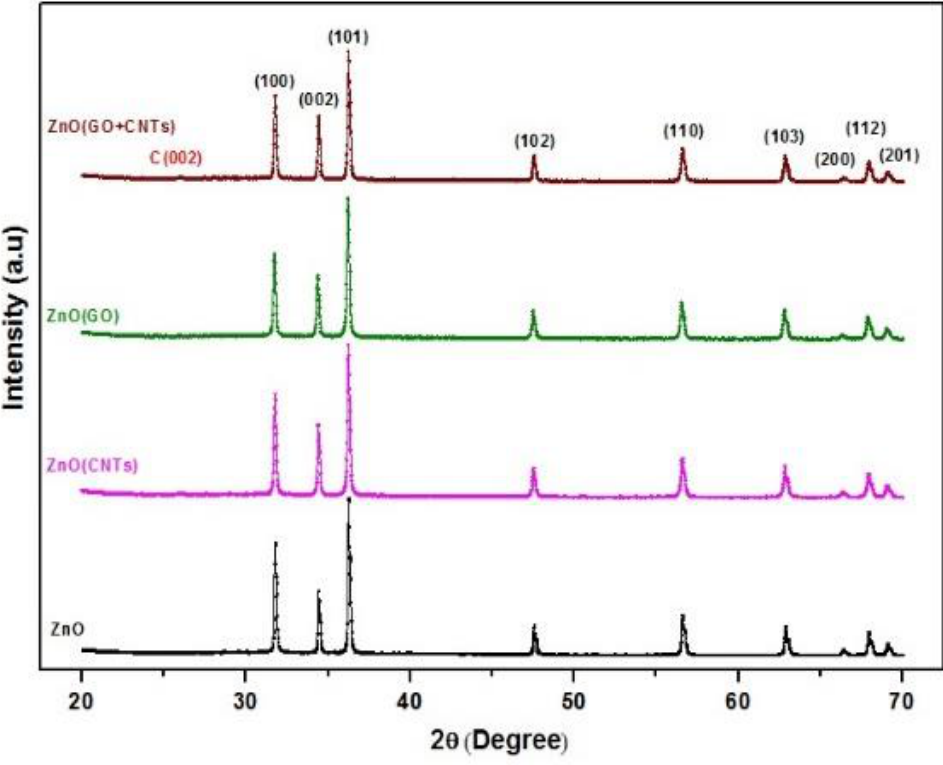
Figure 2. XRD pattern of the ZnO, ZnO (CNTs), ZnO (GO) and ZnO/CNTs/GO samples.